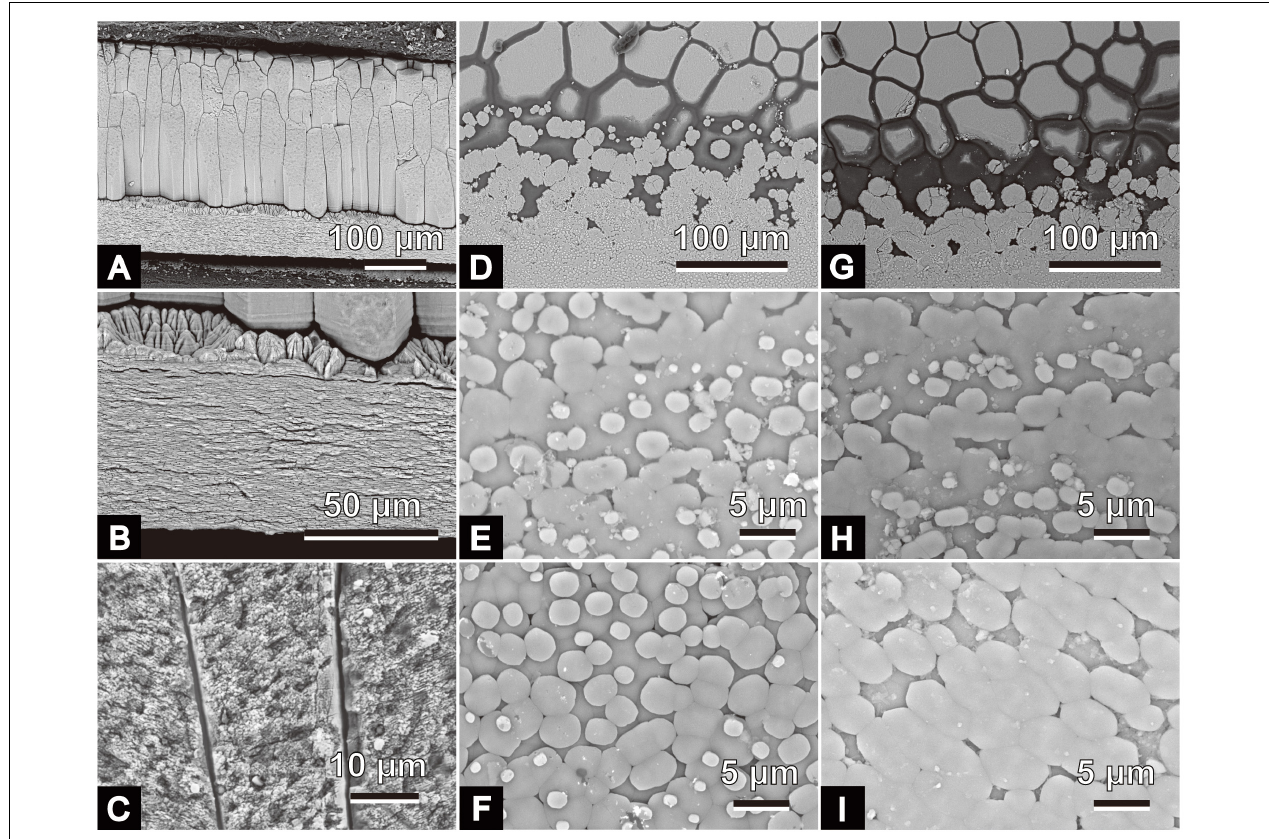
FIGURE 3 | Scanning electron micrographs of microstructures of Pinctada fucata . (A–C) Radial sections of the polished plane. Growth directions (i.e., direction of the shell margin) are on the right side. (A) Outer calcitic columnar regular simple prismatic to middle sheet nacreous structures of a specimen collected on June 26, 2018 (ID: 180626-1). (B) Detailed view of panel (A) ; a thin initial nacreous layer is visible between the outer and middle shell layers. (C) Detailed view of the outer shell layer of specimen collected on January 26, 2018; ID: 180126-5). (D–I) : growth front of nacre on the inner surfaces and the upper sides of these images indicate the direction of the shell margins. (D,E) Specimen collected on May 28, 2018, ID: 180528-1. (F) Specimen collected on June 26, 2018, ID: 180626-1; (G,H) . Specimen collected on July 25, 2018, ID: 180725-1. (I) Specimen collected on August 2, 2018, ID: 180802-1. The outer calcitic columnar regular simple prismatic structure and the middle sheet nacreous structure appear on the upper and lower sides of panels (D,G) , respectively.